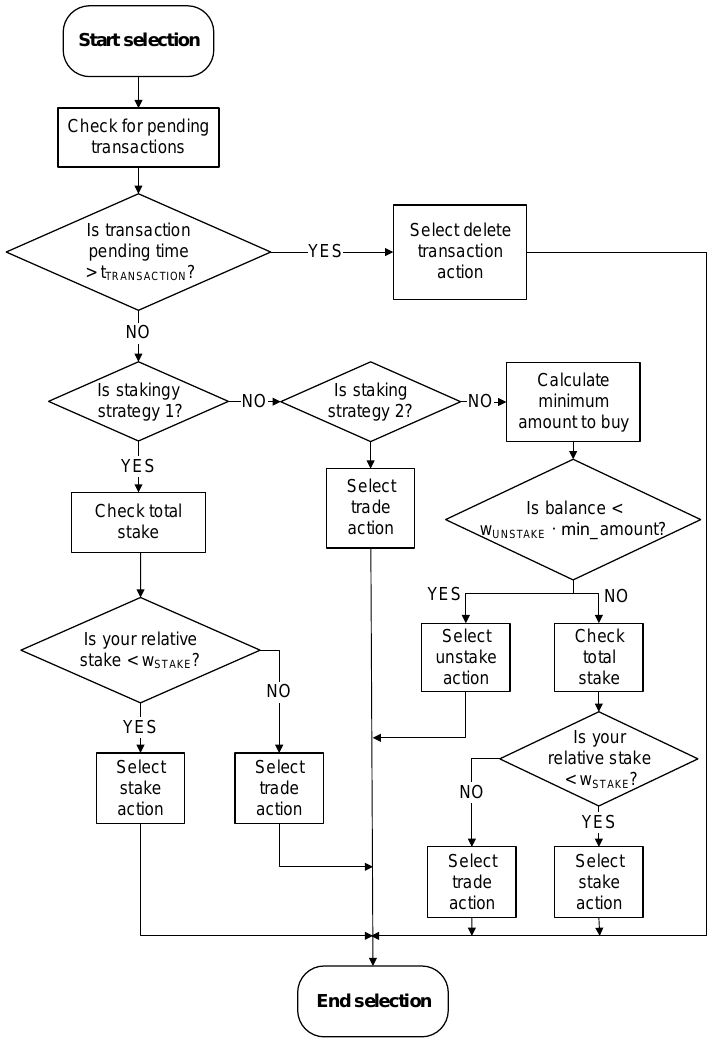
Figure 10. Flowchart of the transaction action decision-making